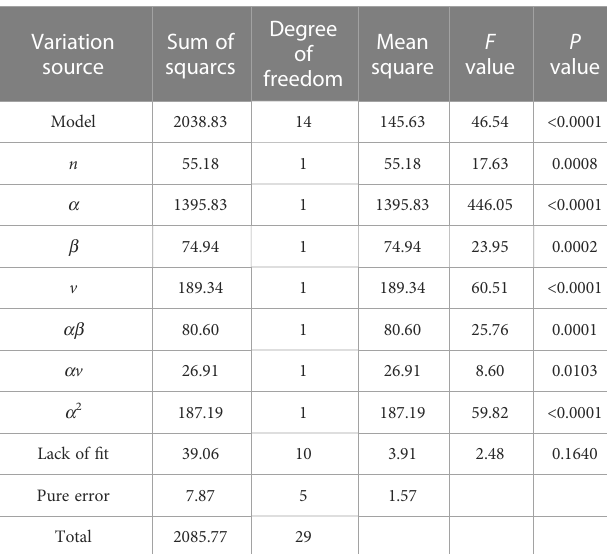
TABLE 3 ANOVA of coef fi cient of variation of shell fi sh